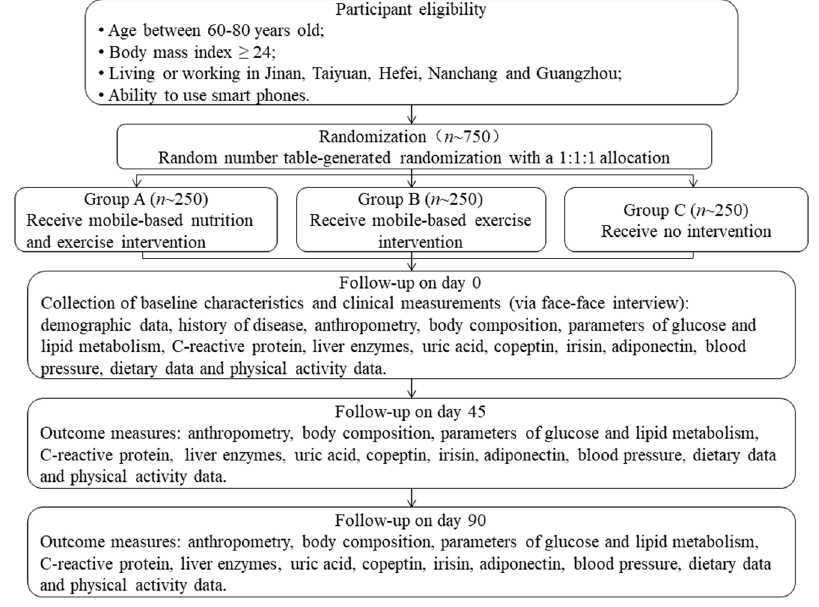
Figure 1. The flow diagram of this